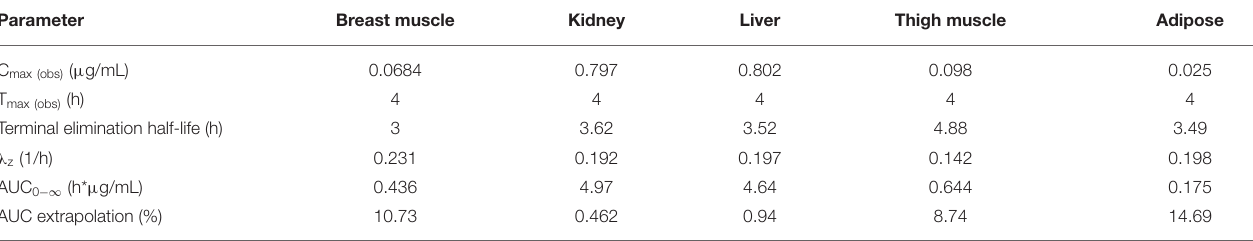
TABLE 4 | Tissue pharmacokinetic parameters estimated from meloxicam concentrations in samples collected from birds at slaughter (at 4, 8, 12, 18, 24, and 30h) following a single 1 mg/kg intravenous meloxicam dose administered to laying hens. Parameter